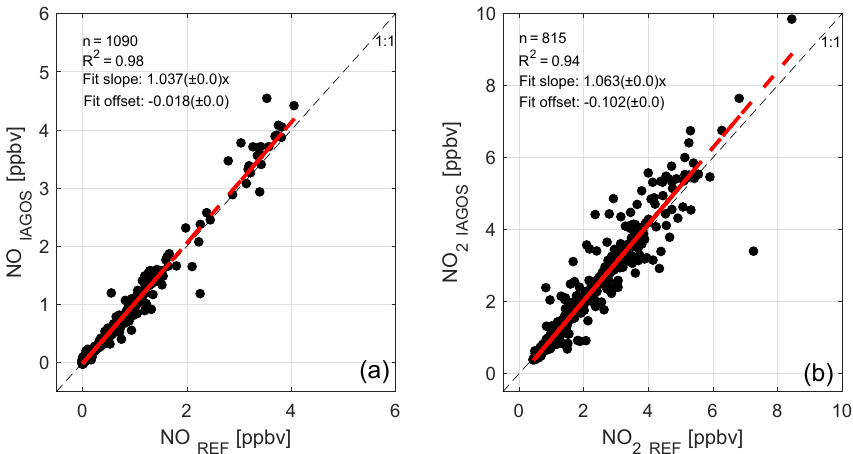
Figure 9. Two days of ambient NO and NO 2 measurements on Hohenpeißenberg in Germany in October 2016 during the ACTRIS NO x instrument intercomparison. The data were averaged to 1min means; no ozone or humidity correction were applied. The reference instrument (REF) was regulary calibrated during the campaign. Table 6. Lifetime, mixing ratio and possible interferences of thermally decomposed reservoir species over different temperature ranges. Values in bold font indicate the most plausible temperature within the NO 2 converter in the IAGOS instrument during flight. Species Lifetime of the reservoir Interference to NO 2 at Mixing ratio at cruising altitude species at 250hPa in s 250hPa in % (source) 300K 320K 340K